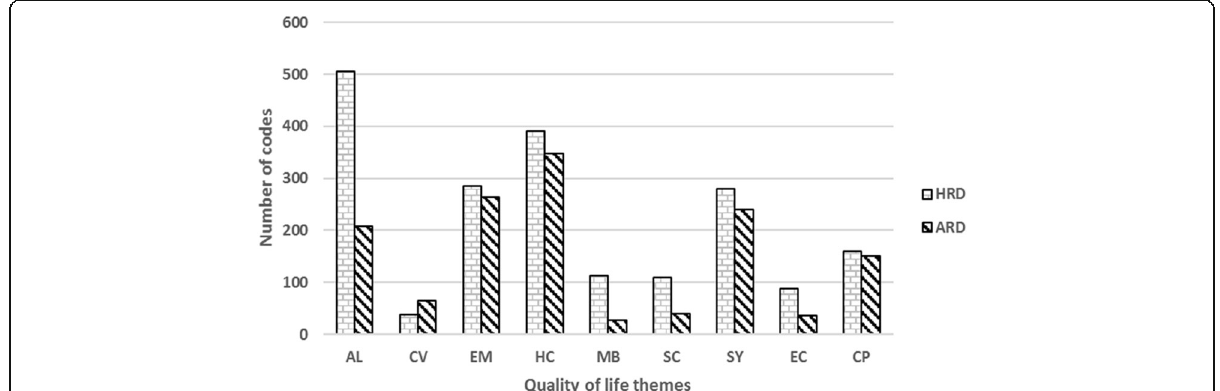
Fig. 2 Quality of life (QoL) themes/domains in hereditary retinal diseases (HRD) and acquired retinal diseases (ARD). Codes = number of times the issue was discussed across all the transcripts analyzed. X-axis represents QoL themes/domains and Y-axis represents number of coded segments for each QoL theme/domain. AL, activity limitation; CV, convenience; EM, emotional well-being; HC, health concerns; MB, mobility; SC, social well- being; SY, symptoms; EC, economic; CP,